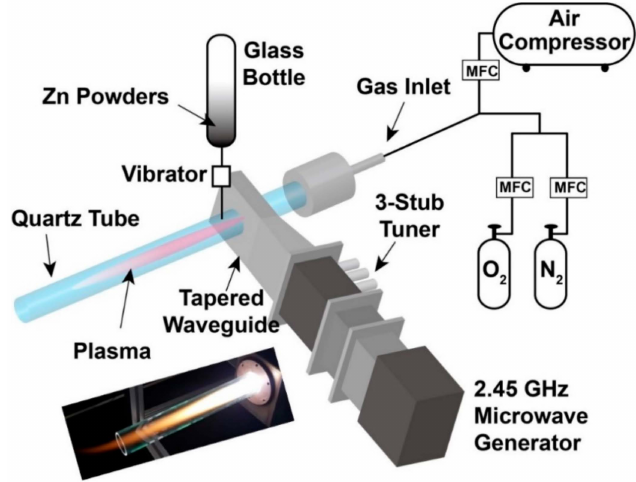
Figure 1. Schematic of microwave plasma system at atmospheric